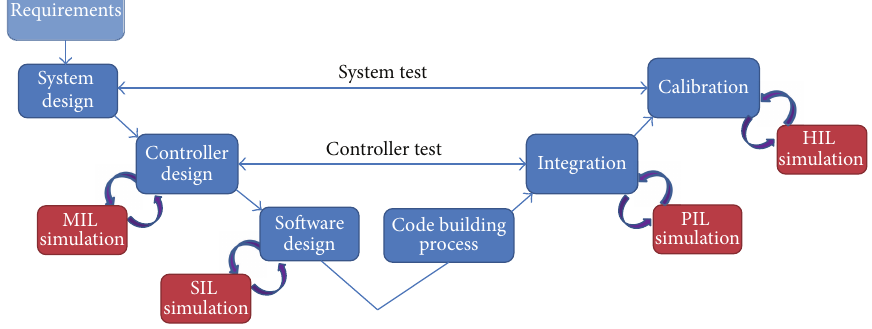
Figure 2: Model-based testing process (adapted from